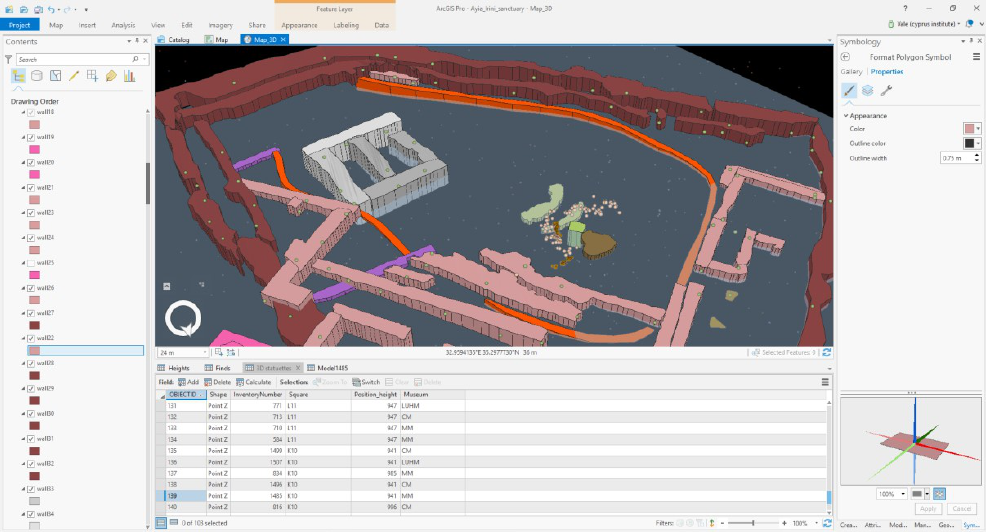
Fig. 1. Reconstruction of the excavation: visualization of the 3D layers and re-positioning of the 3D finds (© author). The digital reconstruction of the site has been performed following the subsequent